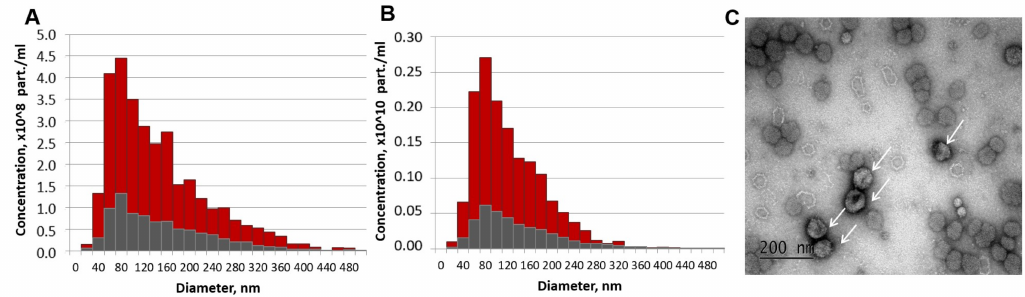
Figure 8. Characterization of extracellular vesicles (EVs) released from mesenchymal stromal cell (MSC) after 48 h of conditioning. ( A , B ) Particle size distributions of EV preparations (red) and control aliquots of MSC-CM after 30 min of conditioning (grey) for non-concentrated ( A ) and 5-fold concentrated ( B ) samples measured by nanoparticle tracking analysis (NTA). ( C ) MSC-EV imaging by the transmission electron microscopy (EVs are indicated by